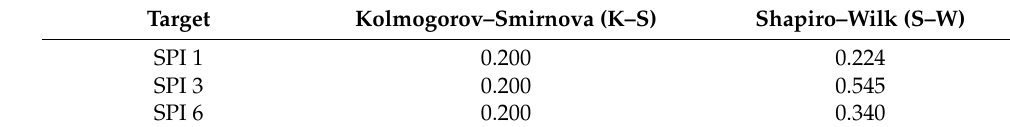
Table 6. Tests of normality.